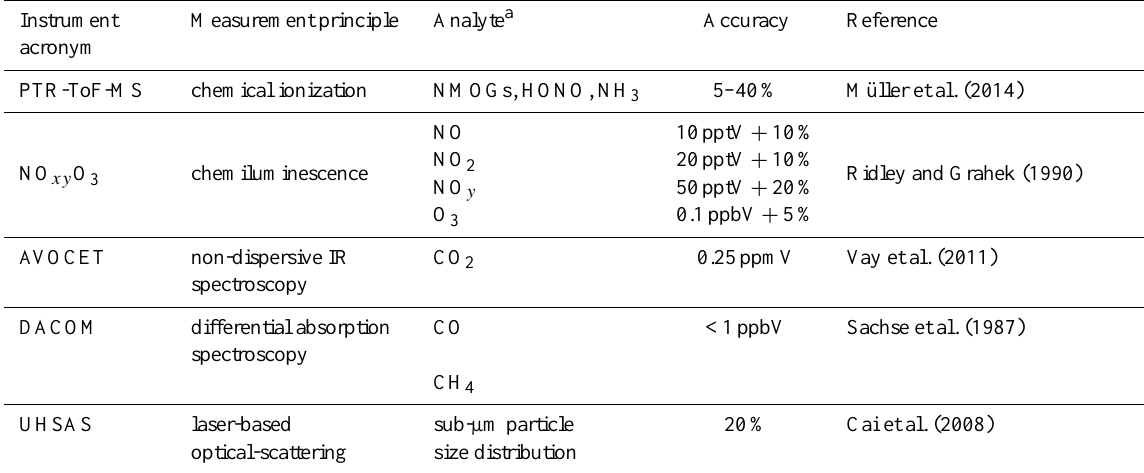
Table 1. Excerpt of the P-3B analytical chemistry